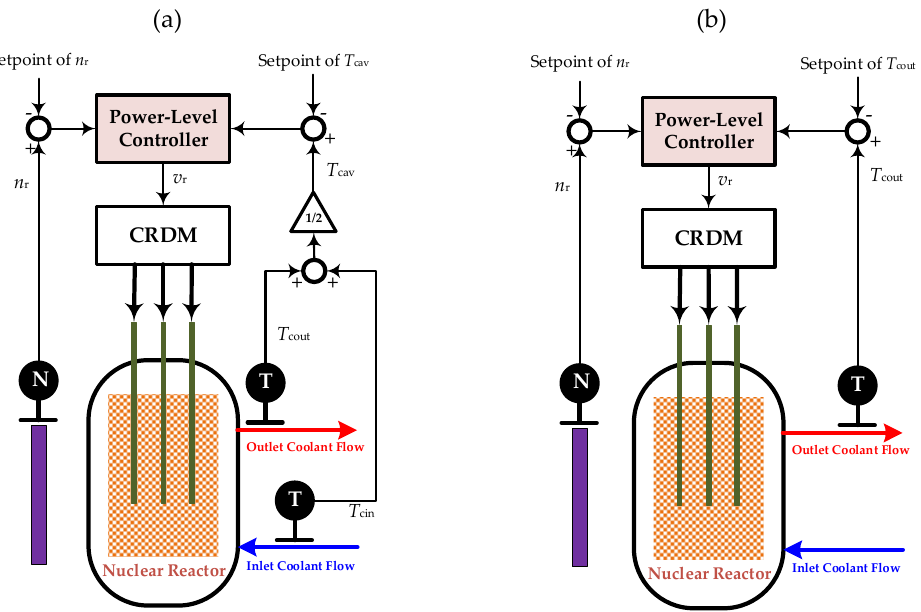
Figure 3. Schematic principle of nuclear reactor power level control, ( a ) power level control scheme for neutron flux and average primary coolant temperature, ( b ) power level control scheme for neutron flux and outlet primary coolant temperature, n r : normalized neutron flux, T cout : primary coolant temperature at the reactor outlet, T cin : primary coolant temperature at the reactor inlet, T cav : average primary coolant temperature, v r : control rod speed signal, CRDM: control rod driving mechanism.